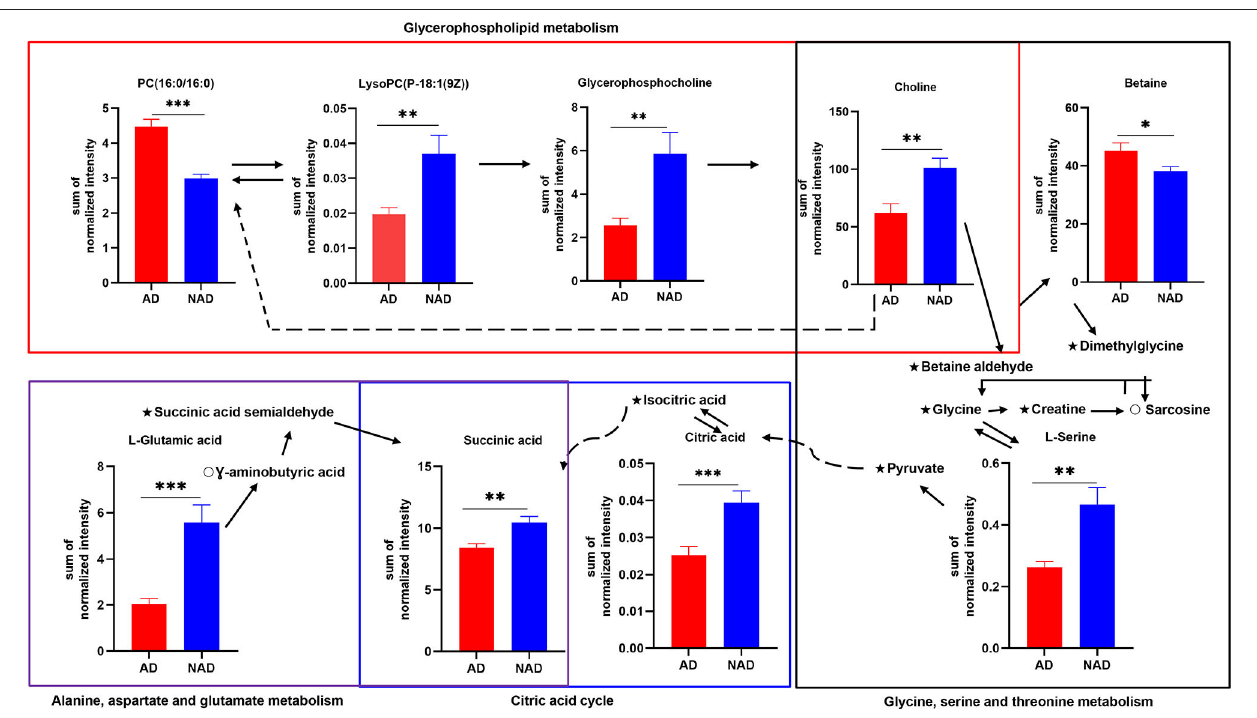
FIGURE 5 | Disturbance of amino acid and glycerophospholipid metabolism in the antenatal depression woman. The key differential metabolites were mainly mapped into the “glycerophospholipid metabolism,” “alanine, aspartate and glutamate metabolism,” and “glycine, serine, and threonine metabolism.” The majority of metabolites of pathways were decreased in the AD group relative to the NAD group. AD, antenatal depression; NAD, non-antenatal depression; PC, phosphatidylcholine; LysoPC, lysophosphatidylcholine. The solid lines show molecular interaction or relation, whereas the dotted lines show indirect or unknown links. Student t test; * p < 0.05, ** p < 0.01, *** p < 0.001, ⋆ , no significance; ◦ , not